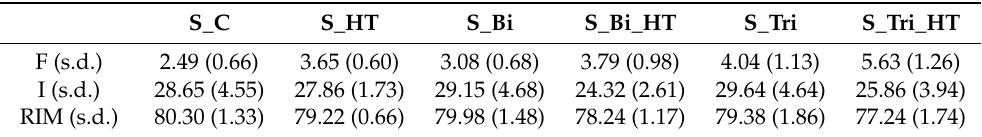
Table 8. HEMI test results for spruce (S). Bi = bicine, Tri = tricine, HT = thermal modification, C = control.